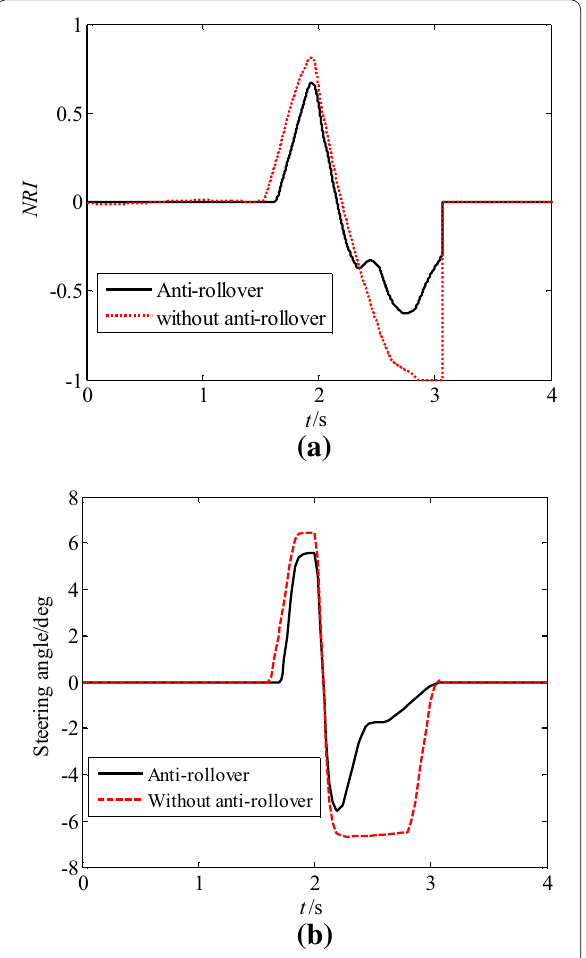
Figure 7 Rollover stability of the intelligent heavy truck in Scenario